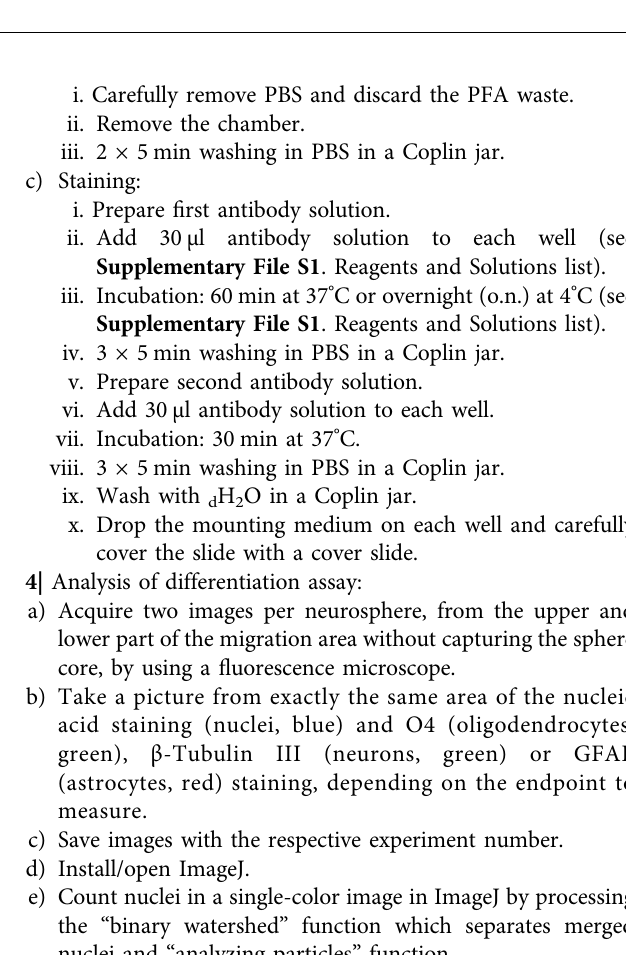
FIGURE3| SchematicrepresentationofthetimelinecorrespondingtotheproceduresdetailedinProtocols2(rabbitneurospherepreparation)and3(neurosphere Assay). ECM: extracellular matrix; GD: gestational day; PND: postnatal day.